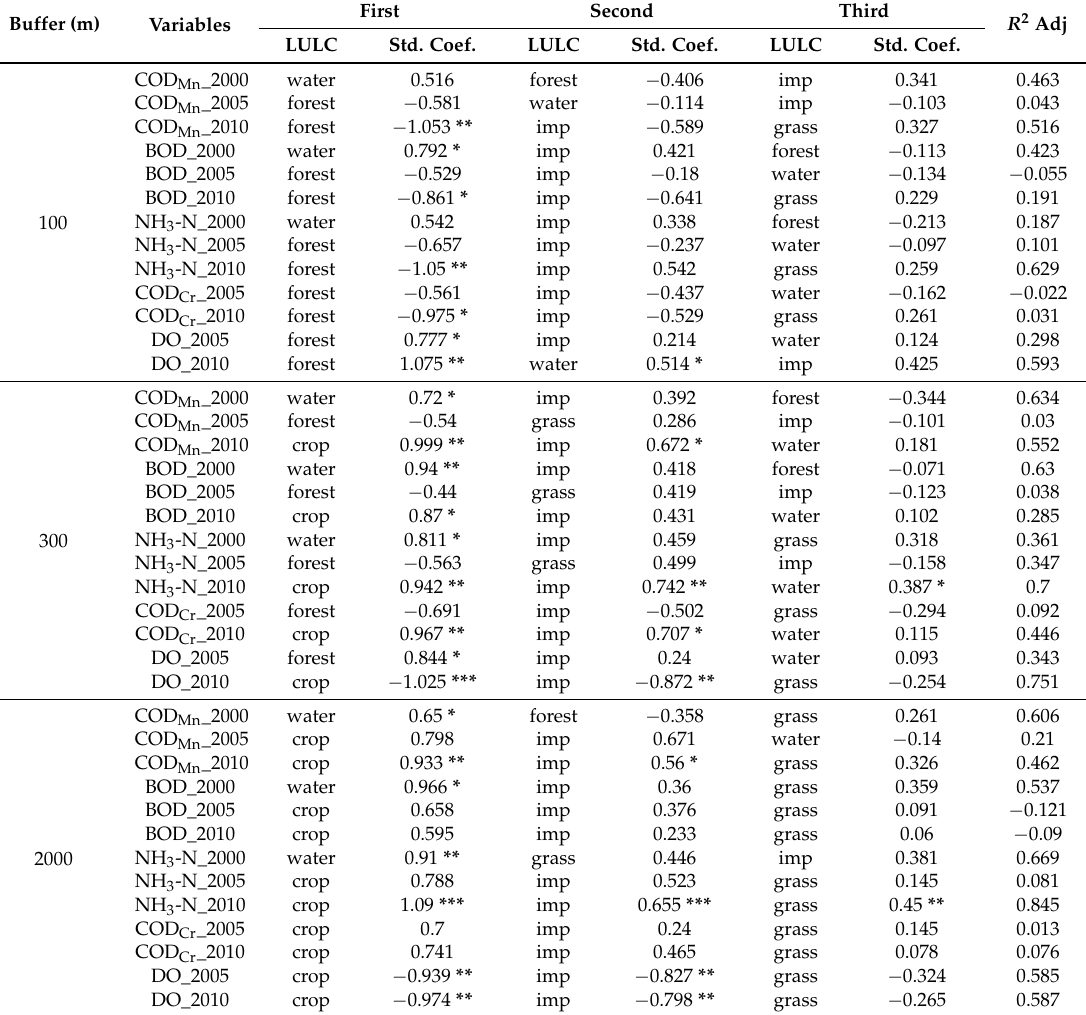
Table 3. Summary of multiple regression analysis between LULC types in 100 m, 300 m, and 2000 m buffer sizes and water quality variables. We list the three most important LULC variables, based on their standardized coefficients (Std.